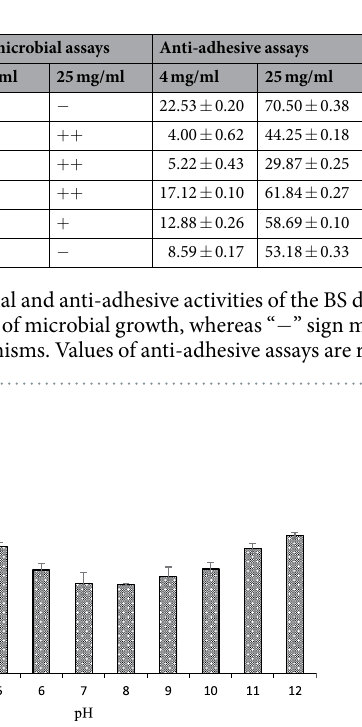
Figure 5. Stability study of BS derived from P. dextrinicus SHU1593 at different pH values. Results are expressed as mean ± standard deviations of values from triplicate